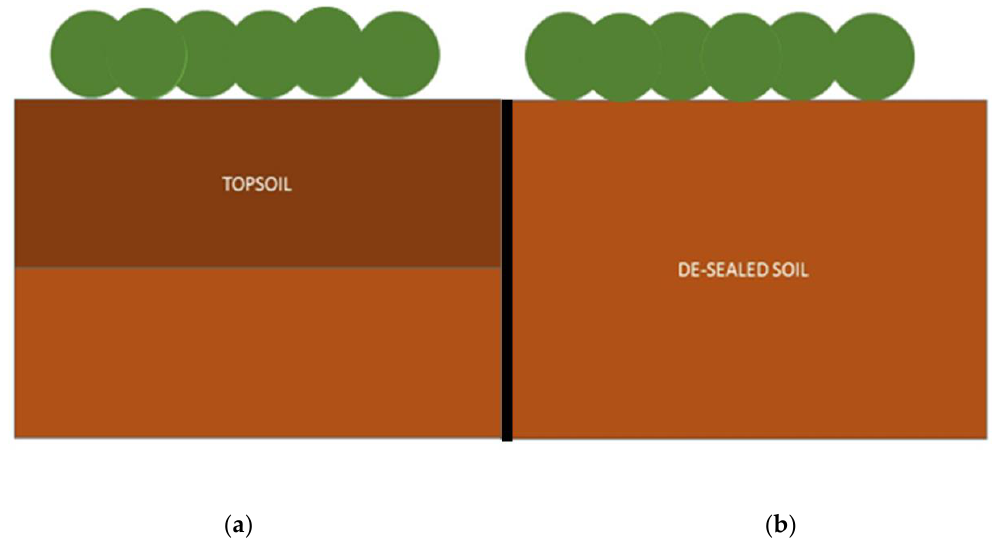
Figure 2. Graphic representation of experimental plots: ( a ) Topsoil subplot (left); ( b ) De-sealed soil subplot (right).